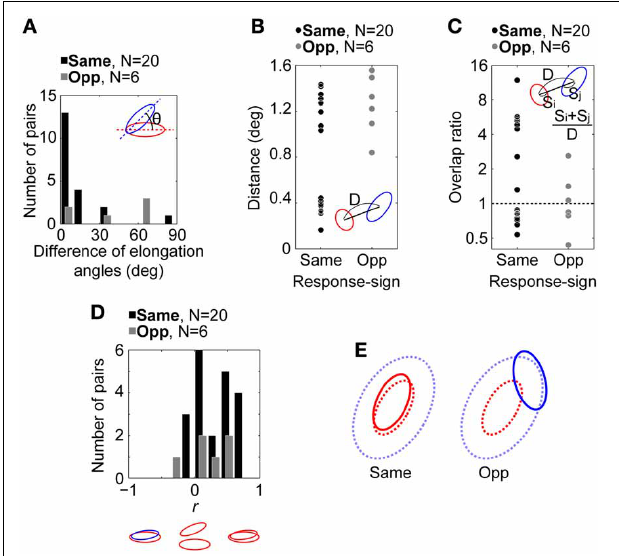
FIGURE 5 | Relationship between the spatial RF structures of retinogeniculate-connected pairs ( N = 26). (A) Distributions of the difference of elongation angles of the spatial RF structures. (B) Distributions of RF center distances of the pairs. (C) Distributions of the overlap ratios between the antagonistic RF center regions of the pairs. (D) Distributions of r between the spatial RF structures of the pairs. An RGC-LGN neuron pair exhibit completely overlapped RF structures with the same response sign when r = 1 and completely overlapped RF structures with the opposite response sign when r = − 1. In (A–D) , insets indicate schematic spatial RF structures. θ , D, S indicate the difference of elongation angles, distance between RF center positions, and size of spatial RF structure, respectively. Black and gray bars/circles indicate pairs with RFs of the same ( N = 20) and opposite response sign ( N = 6), respectively. (E) Schematic summary of spatial RF structures in the retinogeniculate connections. Solid and dotted lines indicate spatial RF structures of RGCs and the corresponding target LGN neurons, respectively. In same- and opposite-response-sign pairs, RGCs exhibit ON-center and OFF-center RFs, respectively. In both pairs, LGN neuron exhibits ON-center OFF-surround RF.